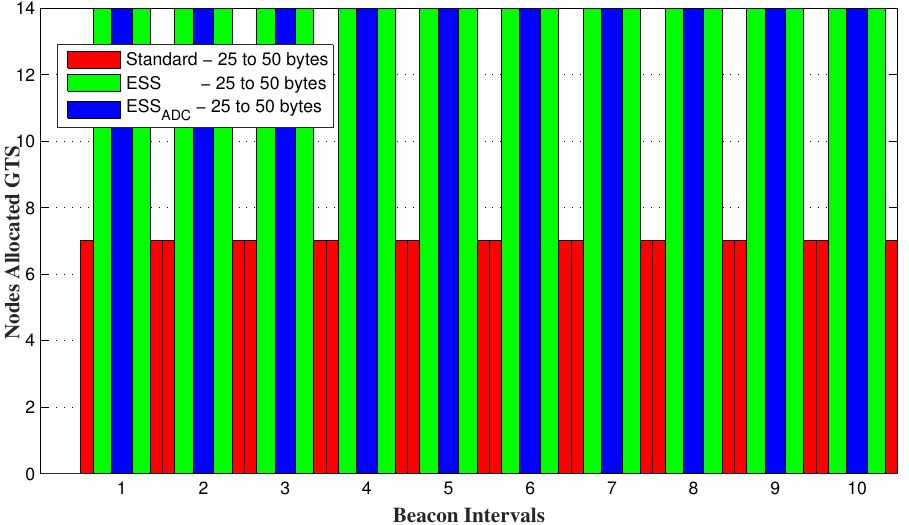
Figure 13. GTS allocating nodes for varying range of fixed data requesting